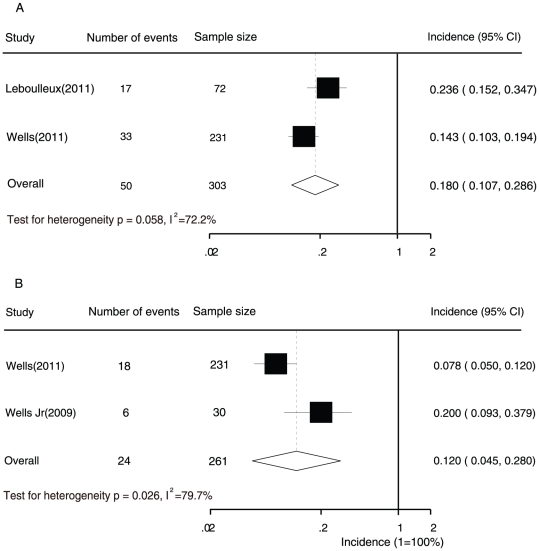
Forest plot for meta-analysis of incidence of all grade (A) and high-grade (B) prolonged QTc interval in patients with thyroid cancer who were assigned vandetanib.